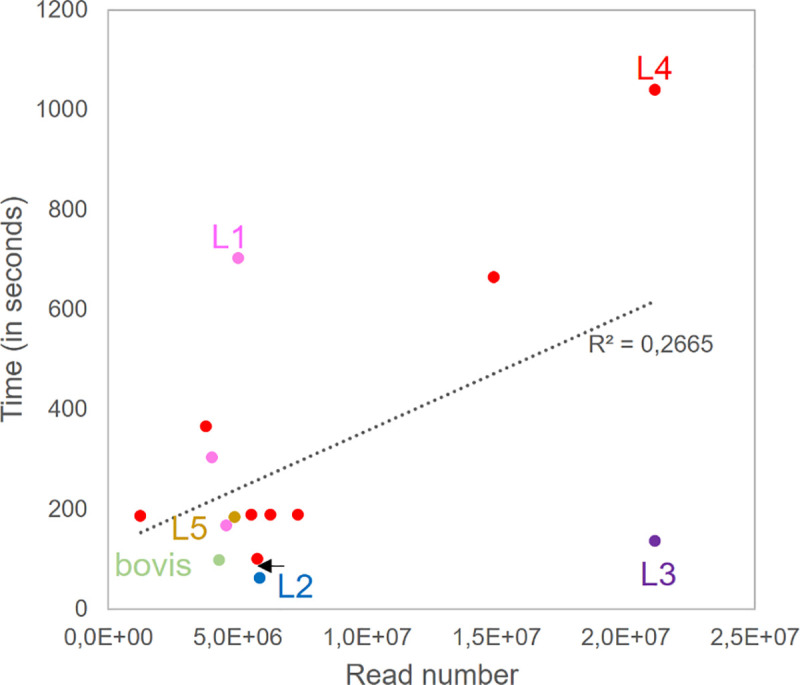
CRISPRbuilder-TB swiftness on a representative sample set.Pink = L1 samples; Blue = L2 sample; Purple = L3 sample; Red = L4 samples; Brown = L5 sample; Green = L6 sample.